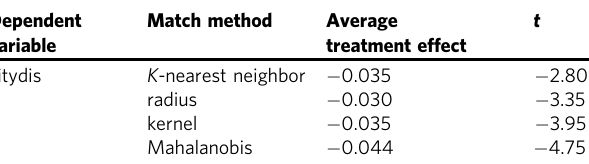
Table 6 Propensity score matching test of the